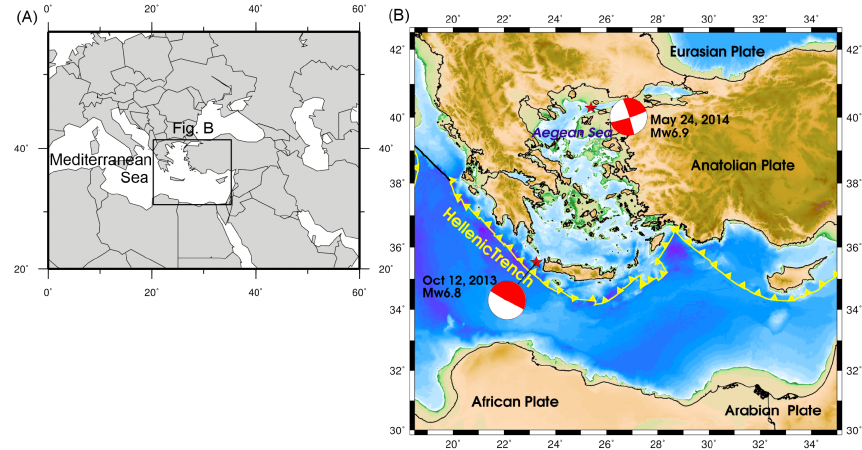
Figure 5. Earthquake events which occurred in the Mediterranean source zone: (a) overview of the source zone; (b) location of the Greece events (red star), their focal mechanisms: a strike–slip faulting and a reverse faulting (red beach ball), and the subduction zone (yellow line).